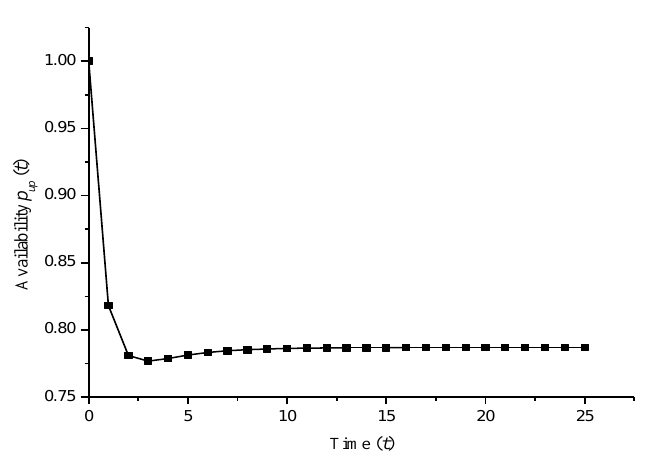
Figure 2. Time dependant availability of the system without copula-coverage.